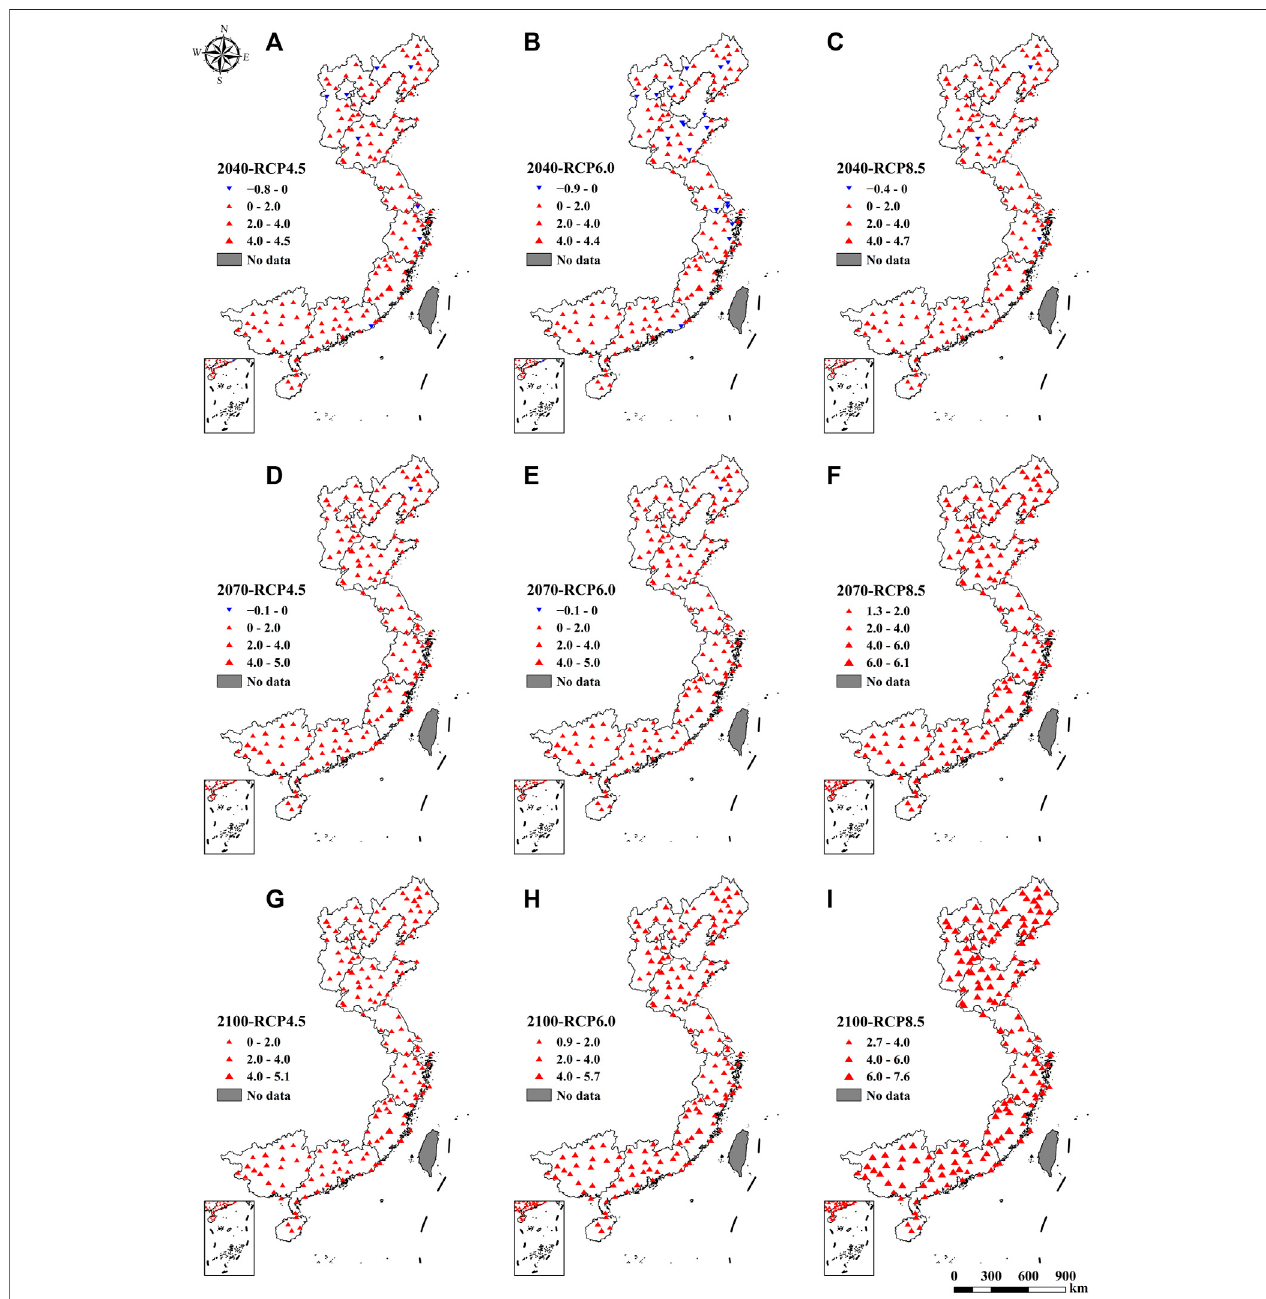
FIGURE 6 | Spatial distribution of changes in annual average Tmean for 2040 with RCP4.5 (A) , RCP6.0 (B) , RCP8.5 (C) , 2070 with RCP4.5 (D) , RCP6.0 (E) , RCP8.5 (F) and 2100 with RCP4.5 (G) , RCP6.0 (H) , RCP8.5 (I) relative to the base period 1996 -2018 at 162 meteorological stations over CAC.